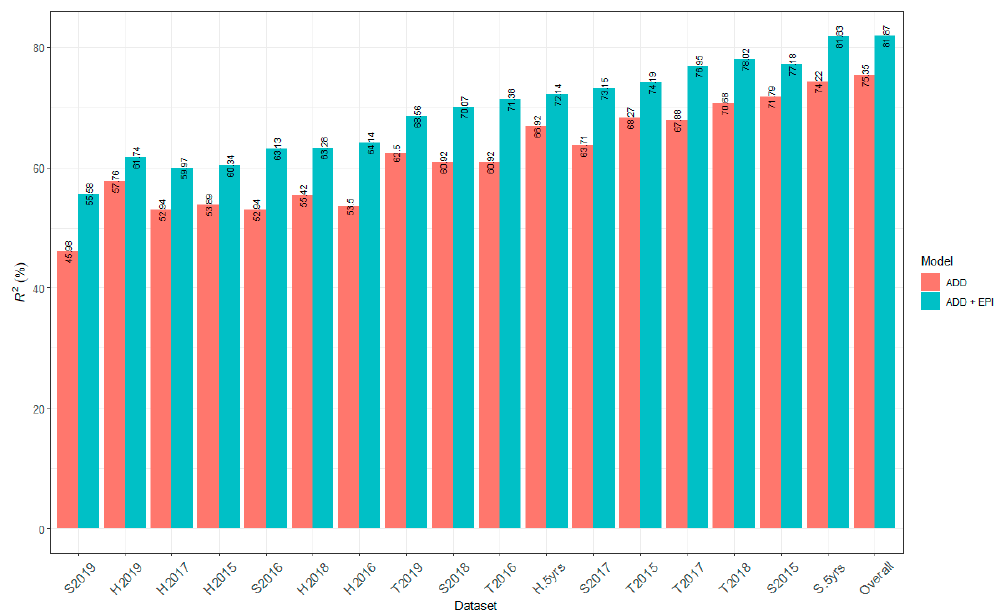
Figure 4. Bar chart of R 2 of 16 additive (ADD) and all 18 additive and epistatic (ADD+EPI) quantitative trait loci (QTL) to the 18 phenotypic datasets of marsh spot resistance index (MSRI). The likelihood-ratio-based R 2 value for each phenotypic data set was calculated as the coefficient of determination in the multiple regression of 16 or 18 QTL on the phenotypic data set using R package MuMln V1.46.0 [32].